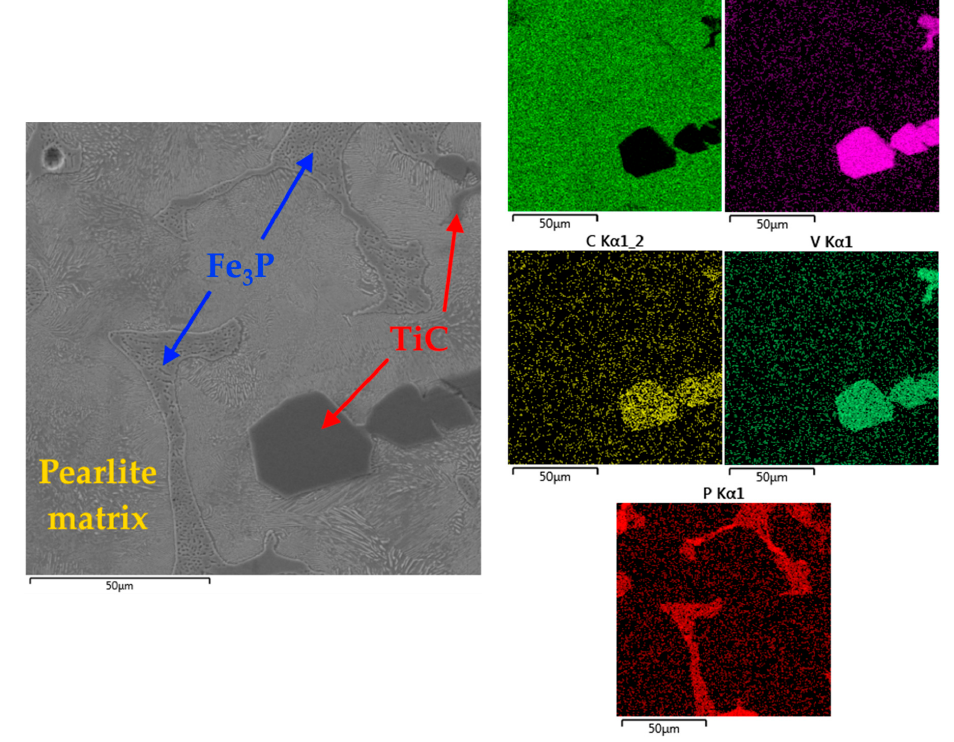
Figure 13. SEM images of the pig iron sample obtained at 1750 ° С (the mapping shows distribution of Fe, Ti, C, V, and P).